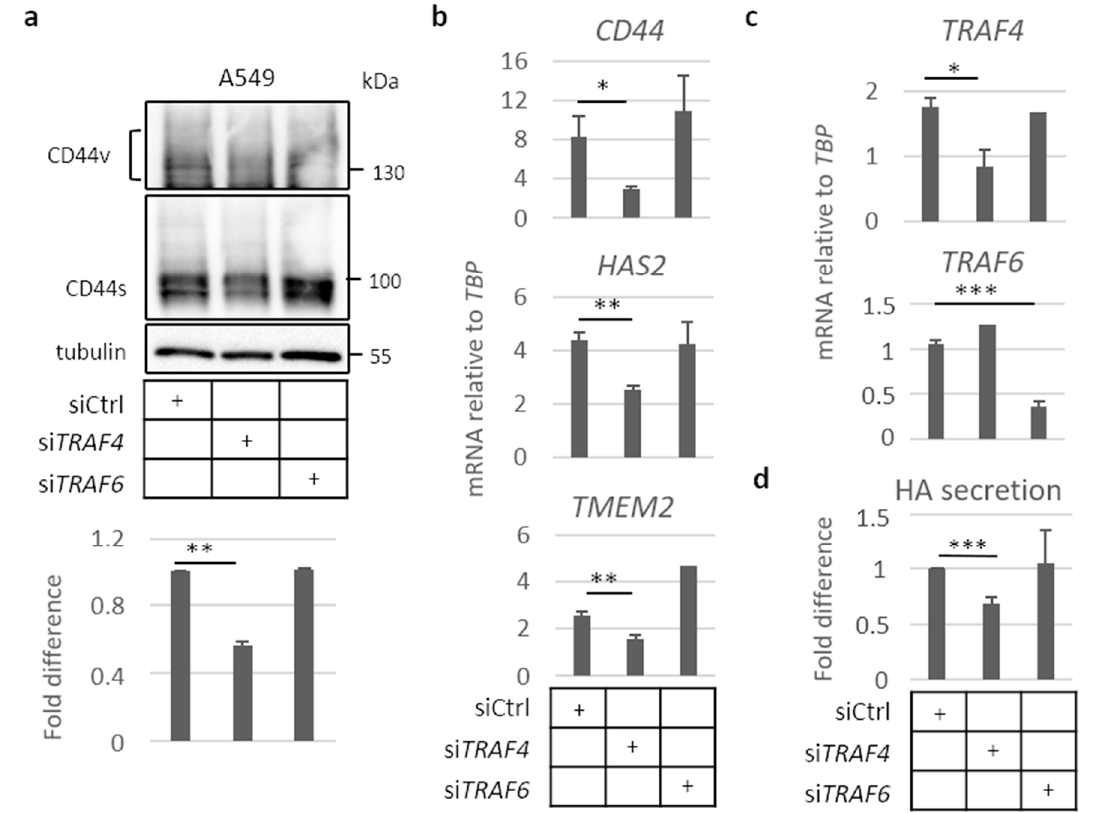
Figure 4. TRAF4, but not TRAF6, is necessary for expression of CD44 and HAS2 in A549 cells grown in spheres. A549 cells were transfected with control siRNA or siRNAs targeting TRAF4 or TRAF6 , and were thereafter seeded in non-adherent conditions for 96 h. ( a ), Cells were collected, and samples were resolved in 8% SDS-PAGE, followed by immunoblotting for CD44s and v isoforms. CD44 bands were quantified by the software ImageJ and normalized to tubulin levels and expressed as fold difference. ( b – c ) mRNA expression of CD44 , HAS2 , and TMEM2 ( b ), as well as TRAF4 and TRAF6 ( c ) were determined by real-time qPCR and normalized to TBP mRNA. ( d ) Hyaluronan levels in the culture medium of cells in low-attachment conditions was quantified by an ELISA-like assay; the results are given a fold difference after normalization to total protein levels of the collected cells. All graph bars are shown as the average ± SEM based from at least three independent experiments. Asterisks illustrate significant differences compared to the siCtrl condition: * p < 0.05, ** p < 0.01, *** p < 0.001.